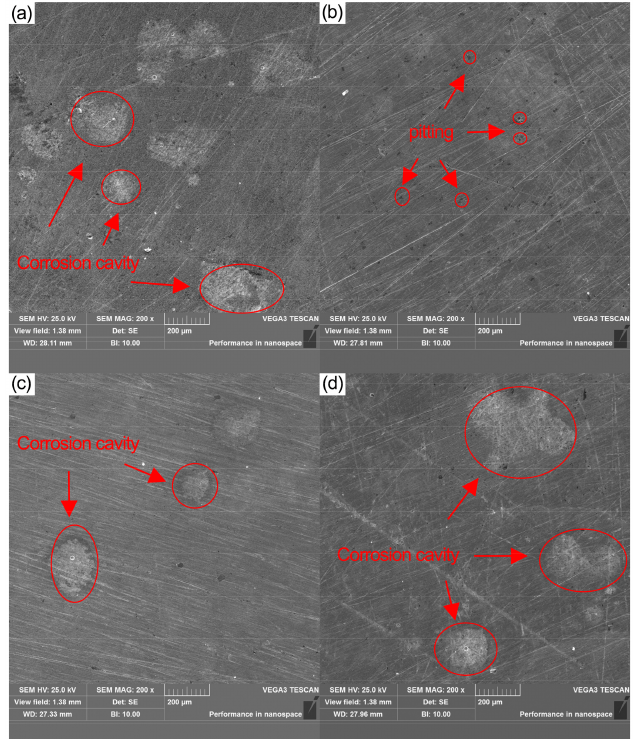
Figure 9. Morphology of different deep cooling temperatures 42CrMo alloy steel after electrochemical corrosion rinsing (SEM, magnification × 200). ( a ) heat treatment ( b ) − 120 ◦ C ( c ) − 160 ◦ C ( d ) − 190 ◦ C.